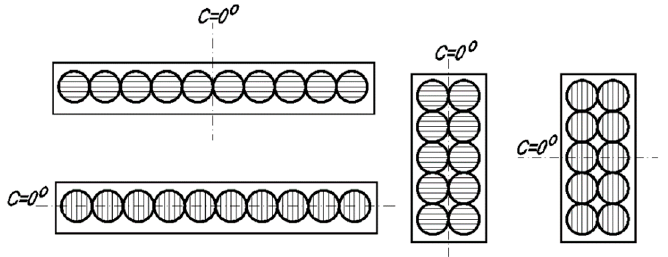
Figure 5. In the multi-source LED luminaires, it is not the luminaire dimension that determines the coordinate system for the luminaire, but the optical system of a single LED chip. The luminaires with the same dimensions may have this coordinate system placed in a different way.